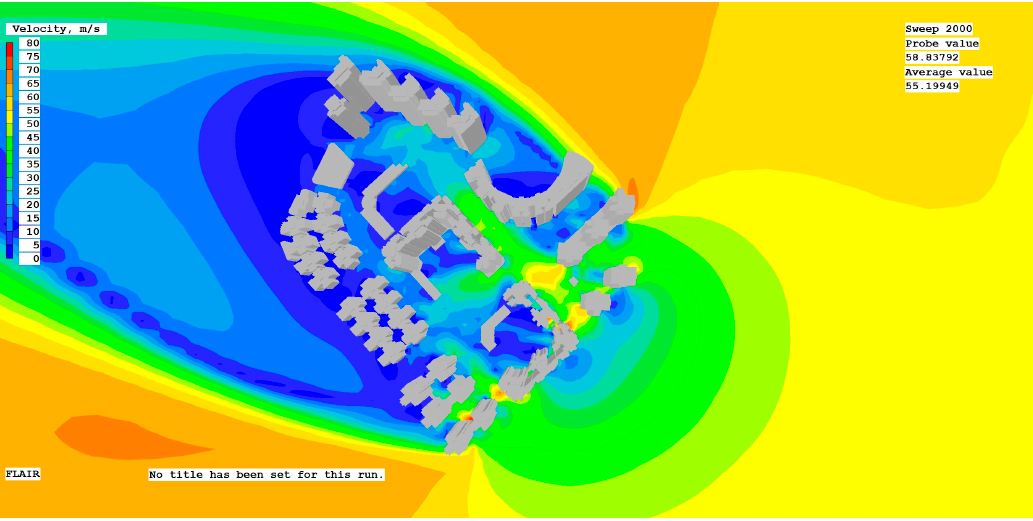
Figure A17. Wind speed distribution under typhoon conditions (10 m height).